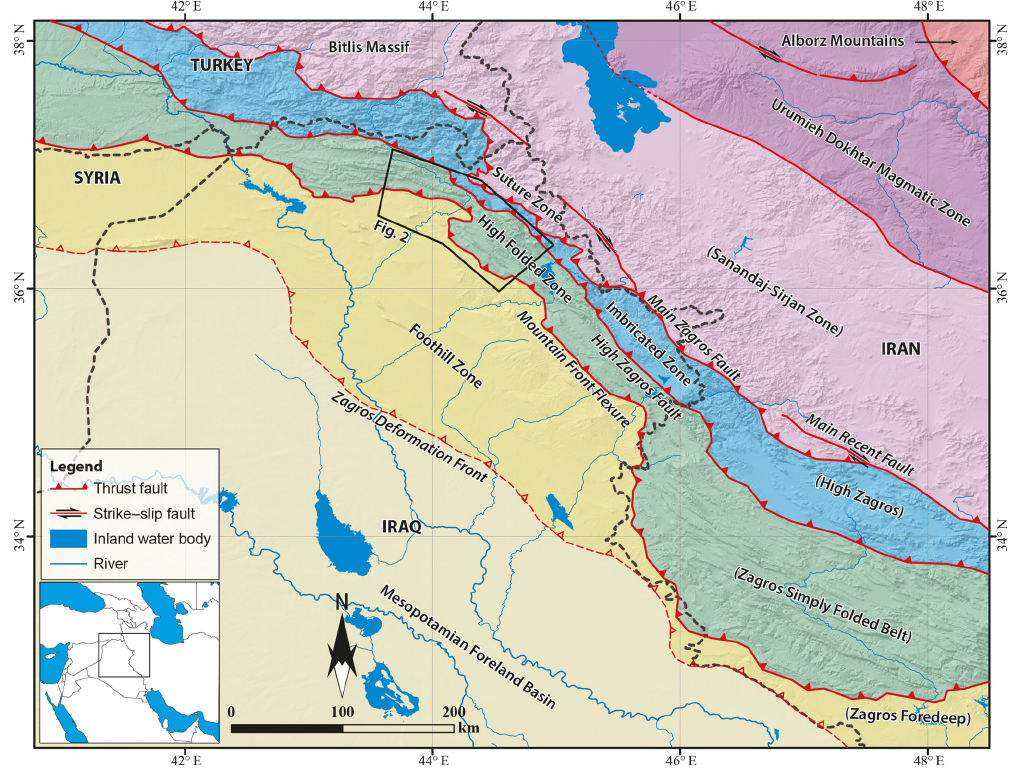
Figure 1. Tectonic subdivision of the NW segment of the Zagros Fold–Thrust Belt (modified after Berberian, 1995; Emre et al., 2013; Koshnaw et al., 2017; Zebari and Burberry, 2015). Names within the parentheses are known in the Iranian part of